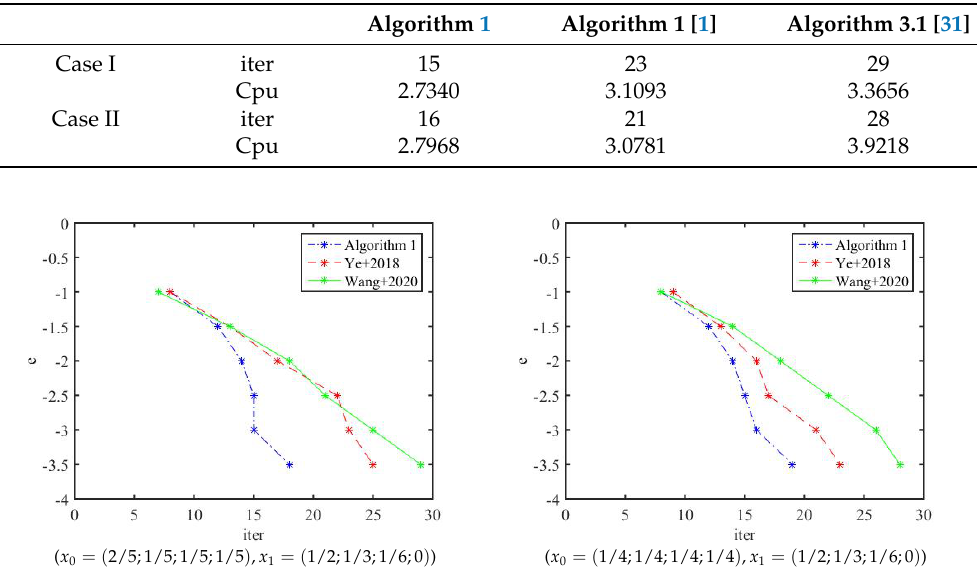
Table 2. Comparison of numerical results of Algorithm 1, Algorithm 1 [1] and Algorithm 3.1 [31] at different initial points under T = T 2 in Example 2.